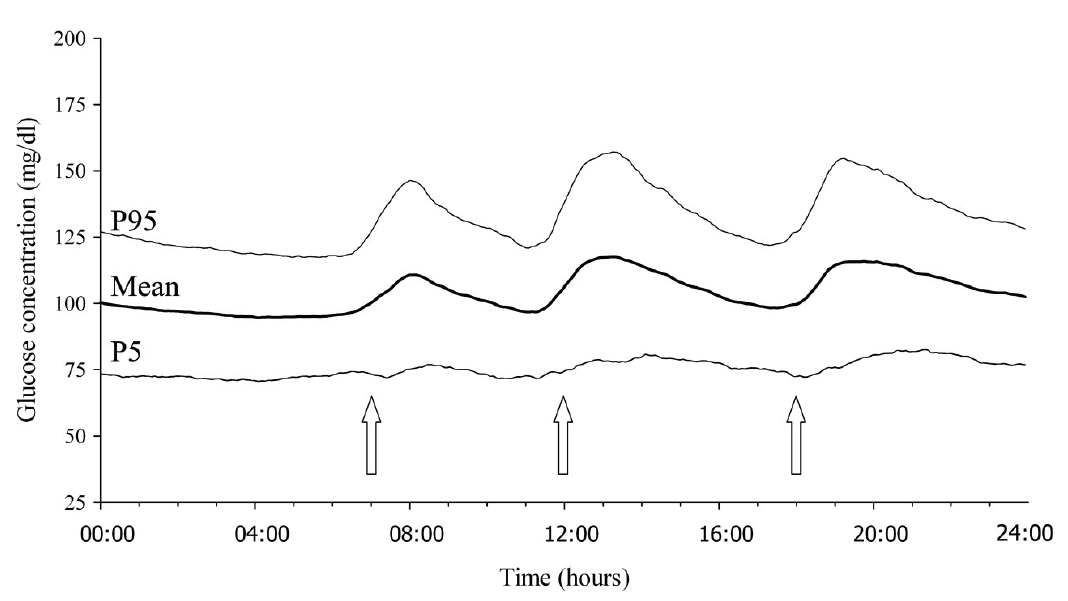
Figure 1. Daily glucose profile in healthy subjects assessed by continuous glucose monitoring. The central line is the mean, and the two outer lines represent the 5th and 95th percentiles (P5 and P95, respectively). Arrows indicate the times of three meals during a day. Reproduced with permission from the American Diabetes Association